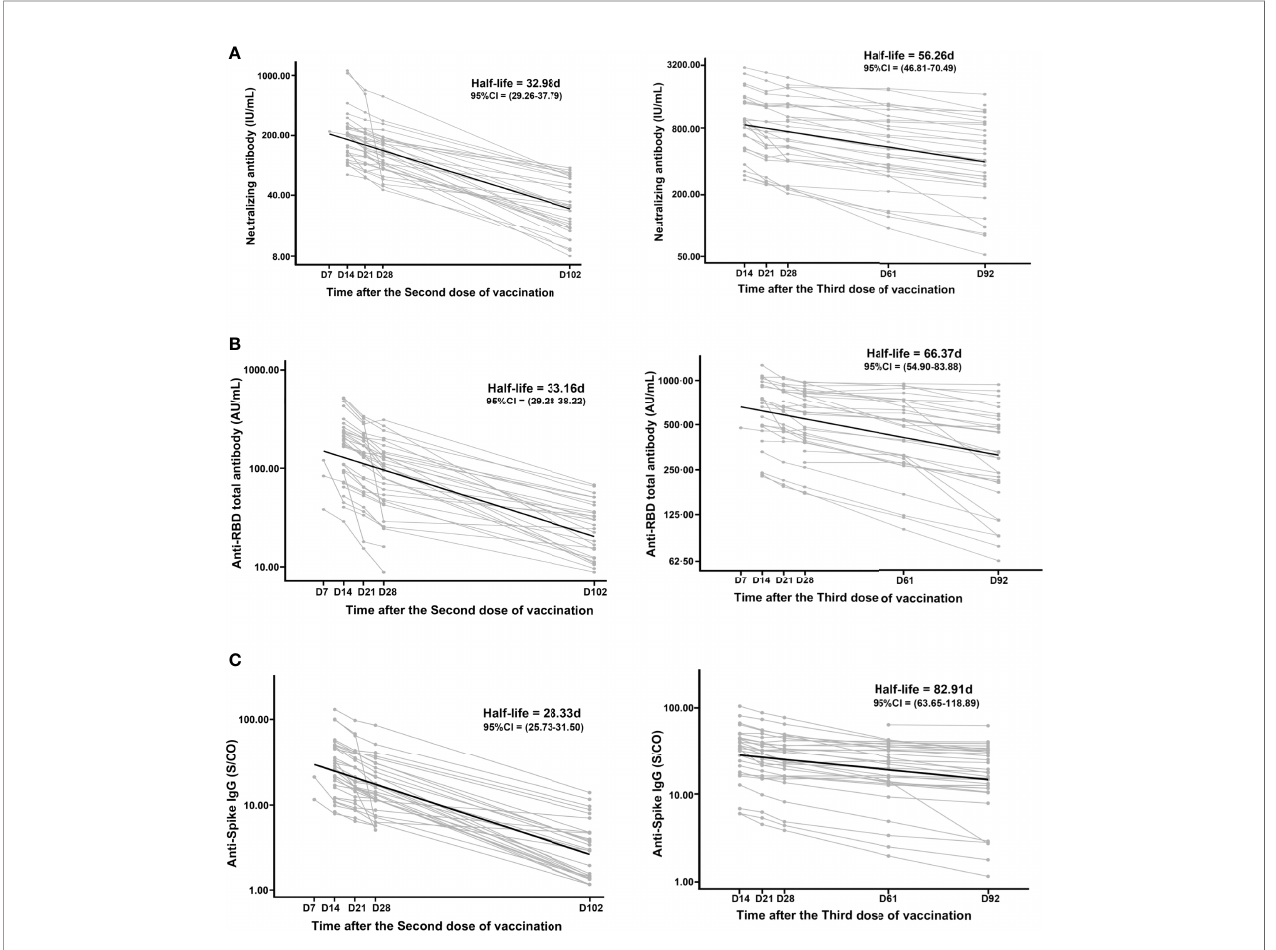
FIGURE 3 | Decay of the anti-SARS-CoV-2 antibodies after the second and third doses. The decay half-lives of neutralizing antibody (A) , anti-RBD total antibody (B) , and anti-Spike IgG (C) were estimated using a linear mixed effects model with censoring of titers above the positive threshold. Due to the small amount of data, the decay half-lives of anti-Spike IgM and anti-Spike IgA failed to fi t the model.